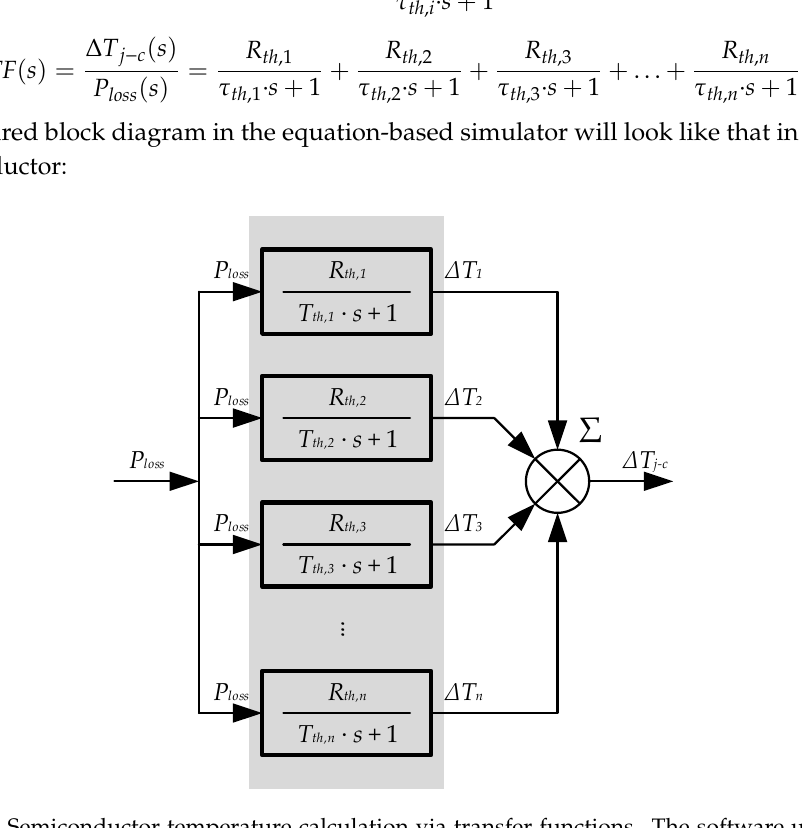
Figure 17. Semiconductor temperature calculation via transfer functions. The software under use is Simulink.